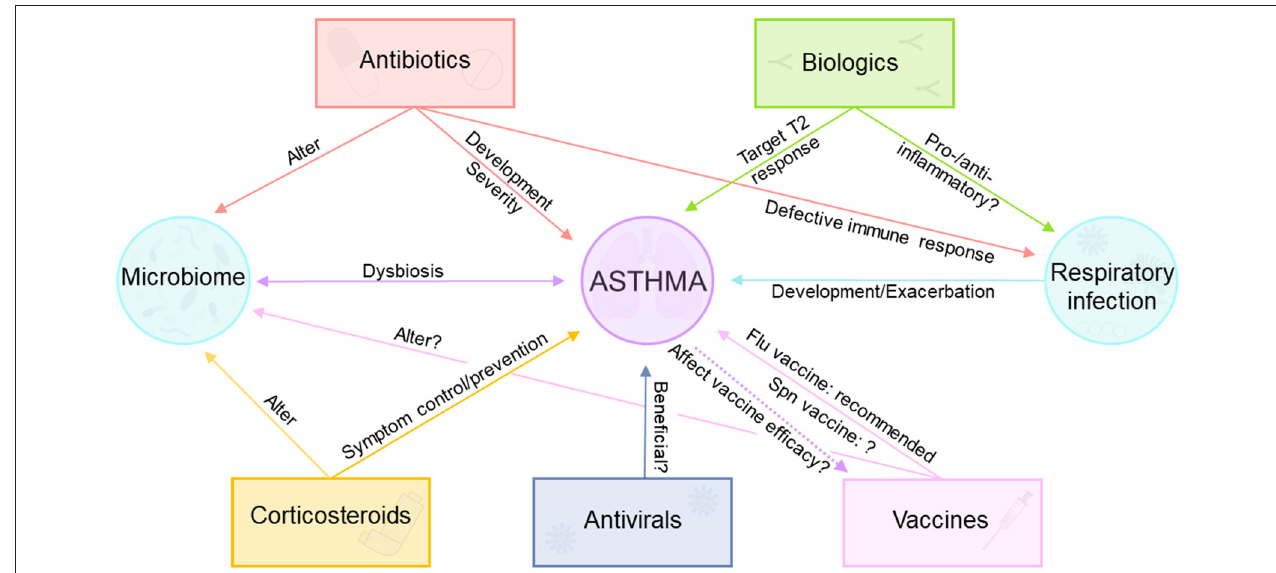
FIGURE 2 | Complex interactions between asthma, asthma therapeutics, and vaccination. Corticosteroids are commonly used for asthma symptom control/prevention, but they alter the airway microbiome. Biologic therapy approved for asthma targets T2 immune response, but their effect during respiratory infections remains unclear. Antivirals may be useful for some asthma patients. Antibiotics cause alterations in the microbiome, are implicated in asthma development and severity, and cause impaired immune responses during viral and bacterial respiratory infections. Influenza vaccine is recommended for patients with asthma, although the usefulness of pneumococcal vaccination is